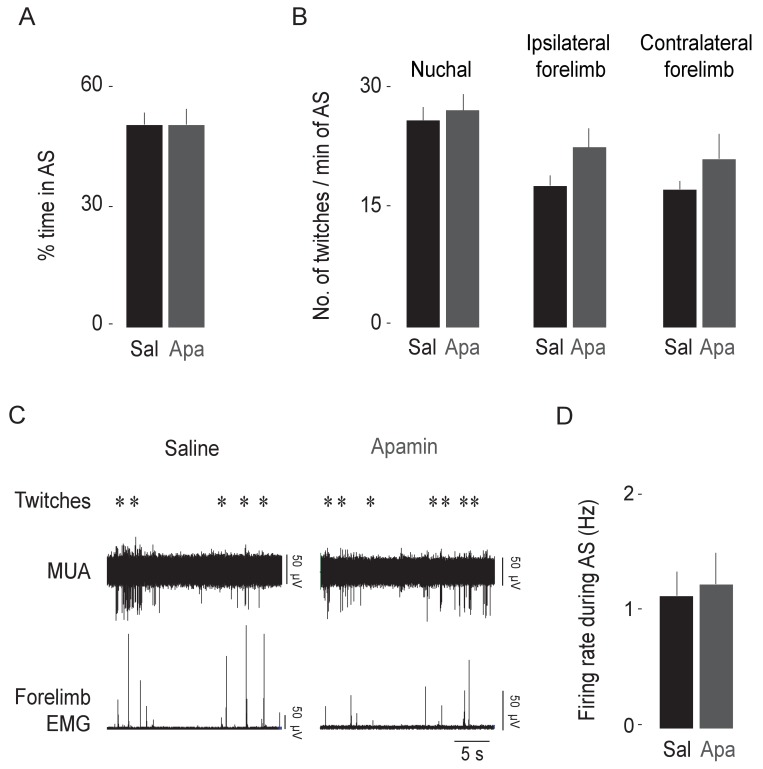
Apamin does not affect sleep-wake behavior.(A) Mean (+SEM) percentages of time spent in active sleep in saline (Sal; n = 10 pups) and apamin (Apa; n = 8 pups) groups. (B) Mean (+SEM) rates of nuchal, contralateral forelimb, and ipsilateral forelimb twitching in saline (n = 10 pups) and apamin (n = 8 pups) groups. (C) Representative recording showing rectified forelimb EMG activity and multiunit activity (MUA) in the IO during spontaneous sleep-wake cycling in pups injected with saline (left) or apamin (right). Asterisks denote twitches as scored by the experimenter. (D) Mean (+SEM) unit firing rates during AS in saline (n = 18 units) and apamin groups (n = 22 units).10.7554/eLife.38213.018Figure 6—figure supplement 1—source data 1.Source data for panels A, B, and D.